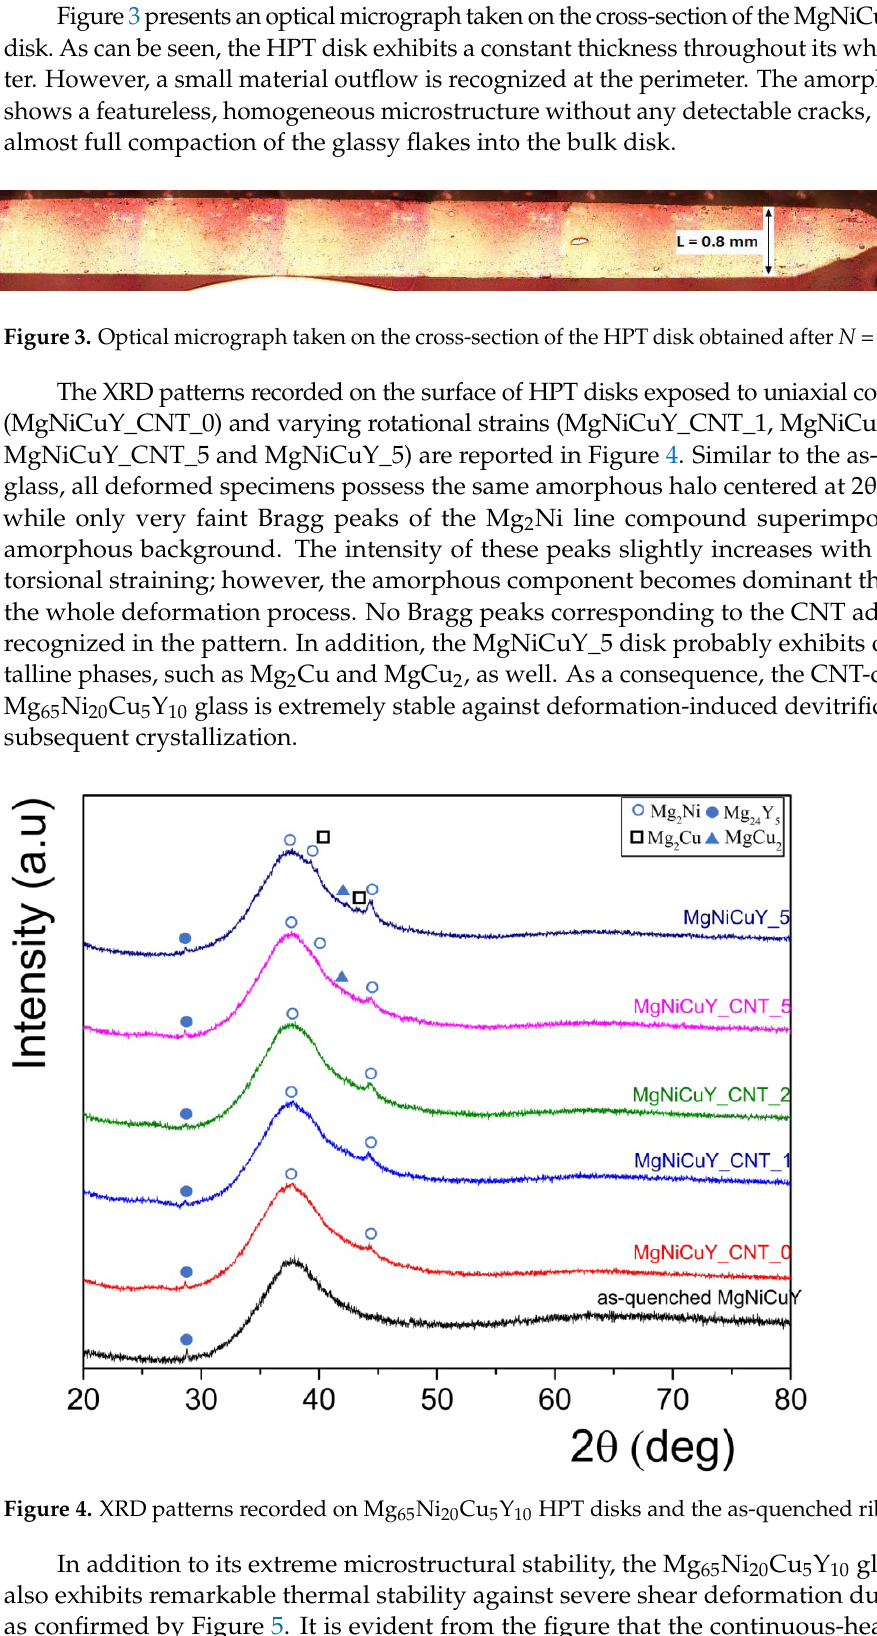
Figure 5. Continuous-heating DSC curves corresponding to the as-quenched Mg 65 Ni 20 Cu 5 Y 10 alloy and CNT-containing HPT disks. The corresponding 𝜂𝜂 values are also listed in Table 1 and presented in Figure 6 as a function of the torsion number. At first glance, it is evident that severe plastic deformation promotes the intensive nucleation of nanocrystals from the amorphous matrix. As one can recognize, the as-pressed MgNiCuY_CNT_0 disk exhibits only 2% extra crystallinity with respect to the as-quenched state, but 𝜂𝜂 increases significantly with the applied torsion number, reaching a maximum value of 𝜂𝜂 = 0.29 for the MgNiCuY_CNT_5 specimen. At the same time, similar deformation conditions yield slightly smaller crystallinity ( 𝜂𝜂 = 0.25) for the CNT-free MgNiCuY_5 alloy. Nonetheless, the massive residual amorphous com- ponent undoubtedly confirms the high stability of the Mg 65 Ni 20 Cu 5 Y 10 alloy.